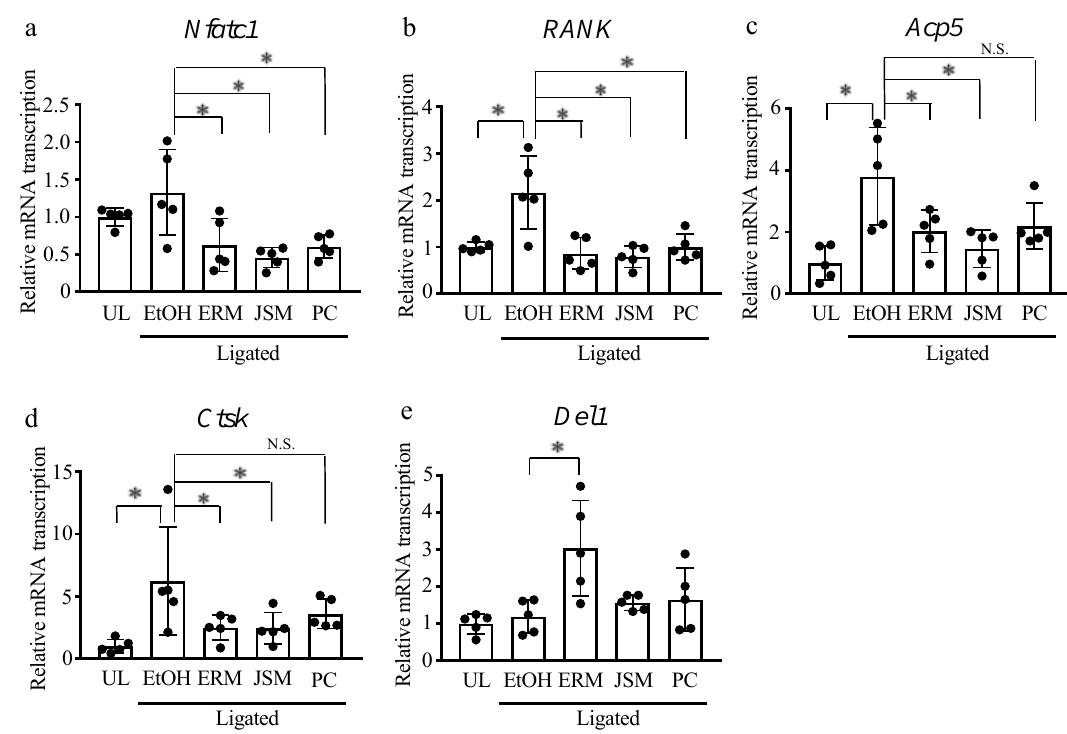
Figure 2. Effect of antibacterial drugs on the transcription of osteoclast-related factors in the gingiva from ligature-induced periodontitis model mice. ( a – e ) Real-time qPCR was performed to quantify the mRNA transcription levels of osteoclast- related factors and Del1 . * p < 0.05 compared to the phosphate-buffered saline (PBS) group, means ± SD ( n = 5 per group). N.S., not significant.